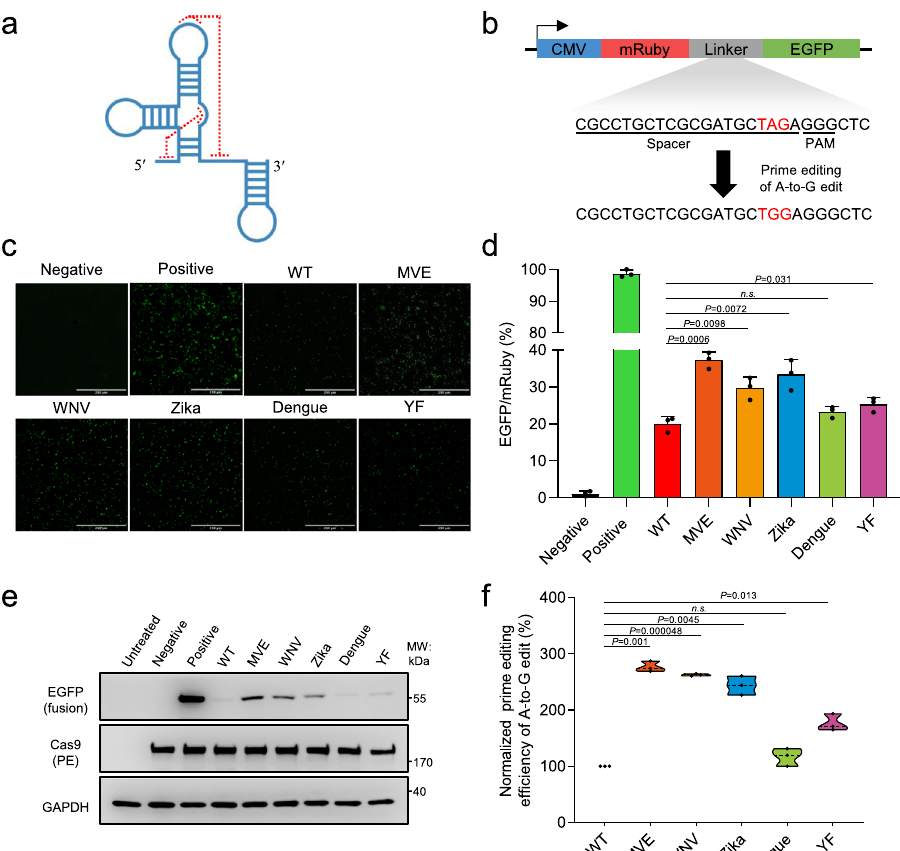
xrRNA motif. Some long-distance interactions (highlighted by red dotted lines) contribute to the formation of a stable knot-like structure. b Illustration